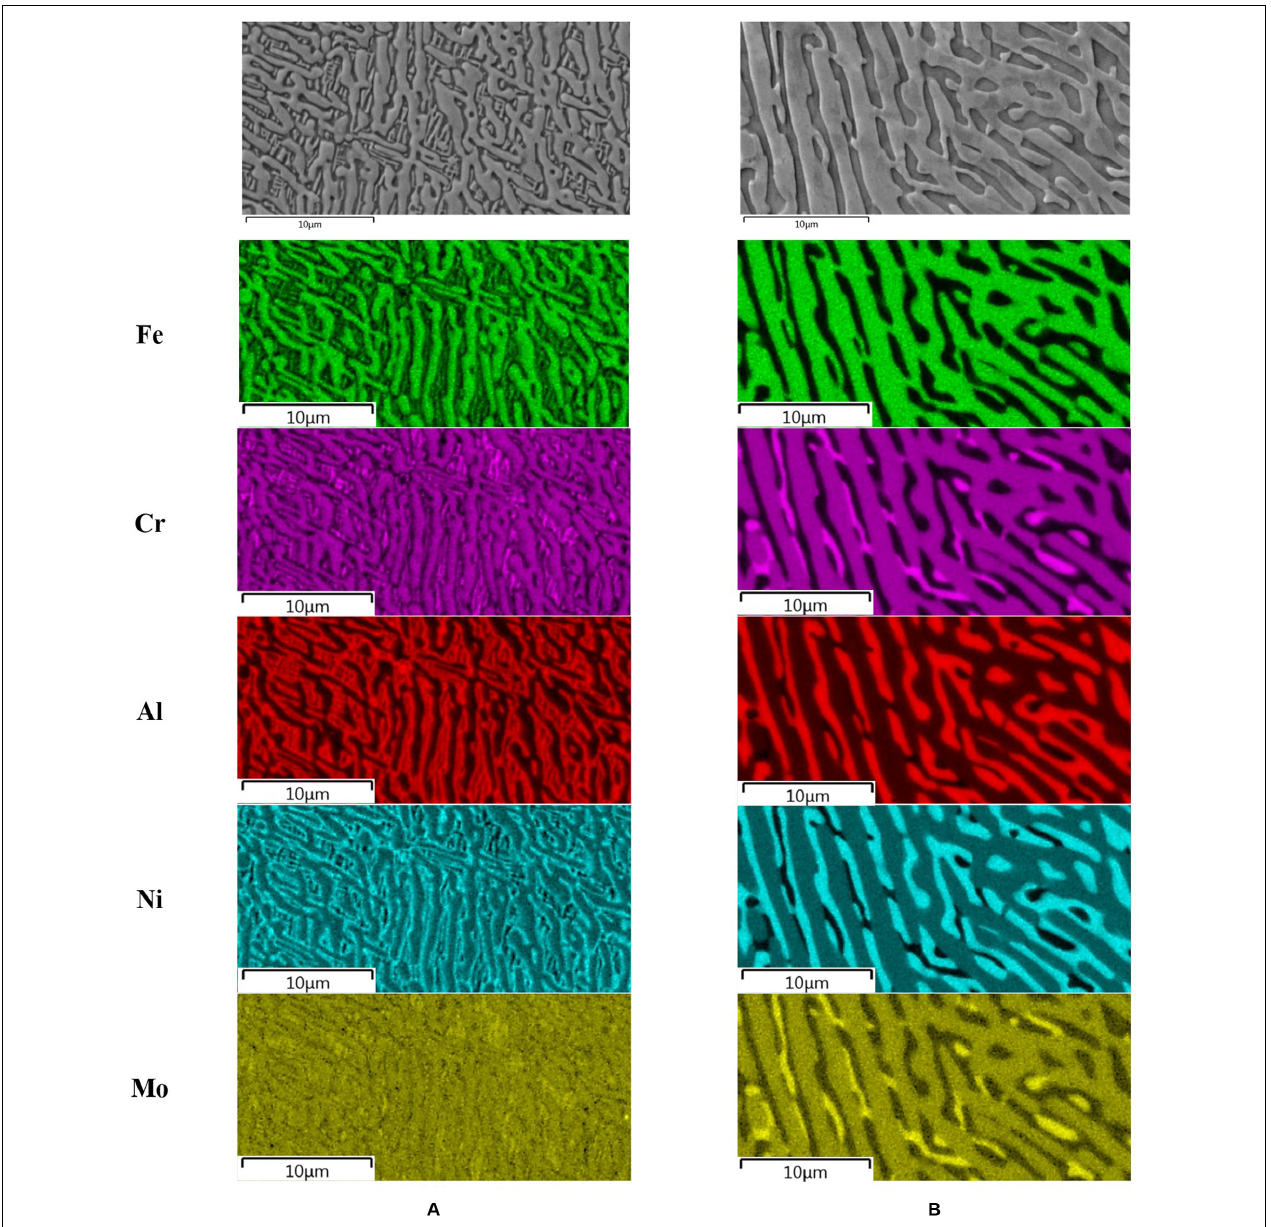
FIGURE 6 | Element distribution from EDS mapping in the sample Mo 2 for (A) as-cast condition and (B) after annealing at 1100 ◦ C for 3 h. Noteworthy is the sluggish partitioning of molybdenum in the as-cast condition, which is recovered after heat treatment.